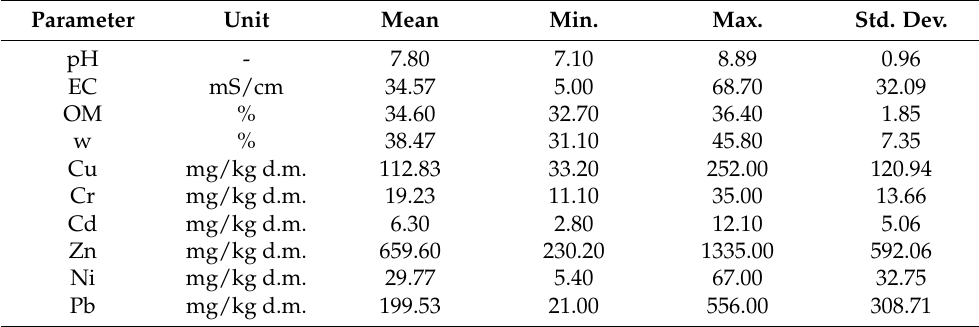
Table 2. The summary of main parameters of substrate applied for biological stabilization of landfill slopes during